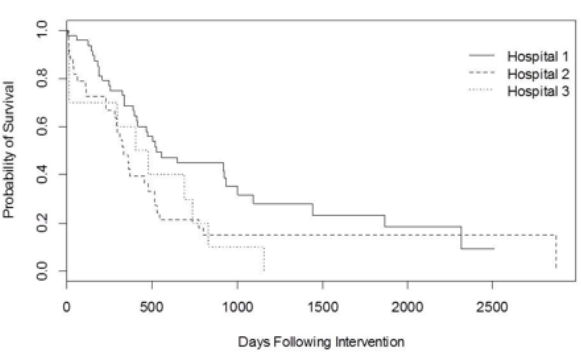
Fig. 1: Kaplan-Meier survival curve as a function of facility.